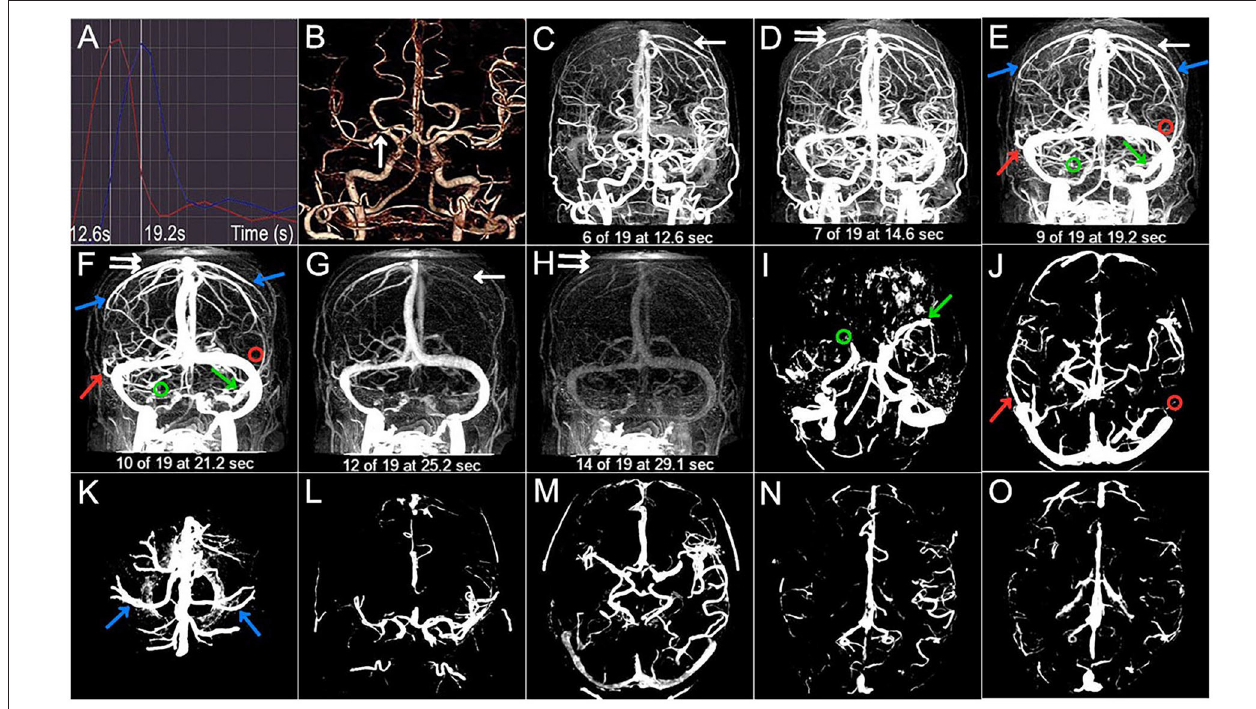
FIGURE 2 | Case 2. A 54-year-old woman with a history of hypertension and diabetes presented with left-sided and left facial droop hemiparesis. The NIHSS score was 5 on admission. 3 months mRS score was 1 (good outcome). (A) The selected arterial and venous phases are 12.6s and 19.2s, respectively. (B) The arrow points to the right M1 severe stenosis. (C–H) The CVF 1 , CVF 2 , CVF 3 , CVF 21 , and CVF 31 of the contralateral hemisphere (white arrow) are 12.6s, 19.2s, 25.2s, 6.6s, and 12.6s, respectively, while the CVF 1 , CVF 2 , CVF 3 , CVF 21 , and CVF 31 of the affected hemisphere (double white arrow) are 14.6s, 21.2s, 29.1s, 6.6s, and 14.5s, respectively. The mean difference between the affected and contralateral hemisphere is 0s for rCVF 21 . (C–K) The presence (color arrow) and the absence (circle) of SMCV (green), VOL (red), and VOT (blue). SMCV- is found in the affected hemisphere, and VOL- is found in the contralateral hemisphere. (L–O) Compromised antegrade flow and poor collateral